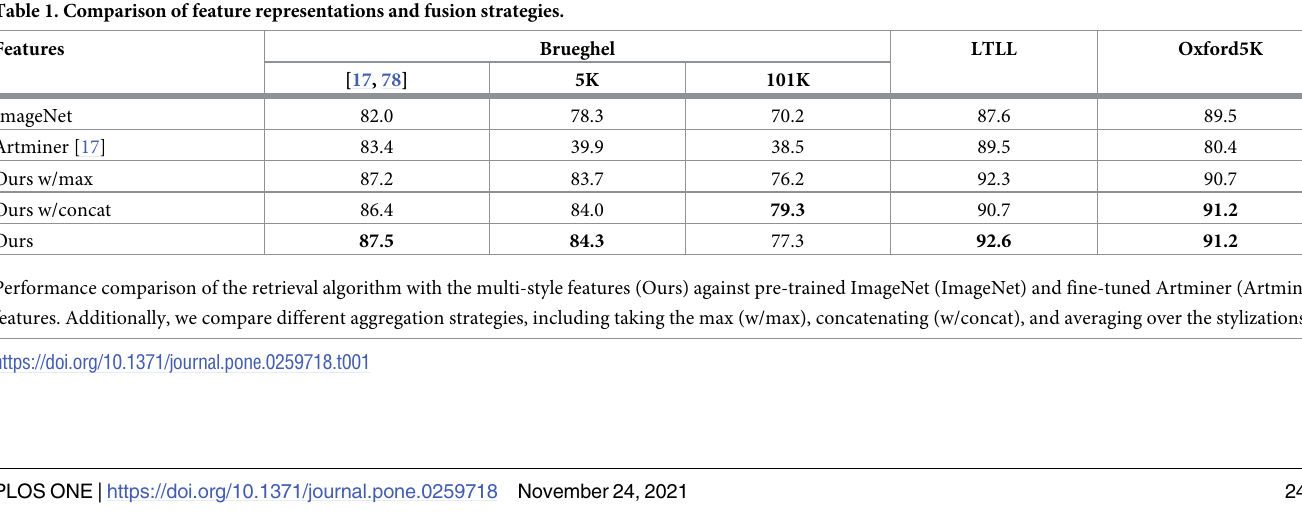
Table 1. Comparison of feature representations and fusion strategies. Features